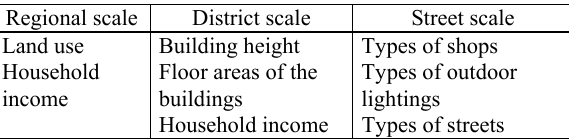
Table 1. Factors analysed at different spatial scales